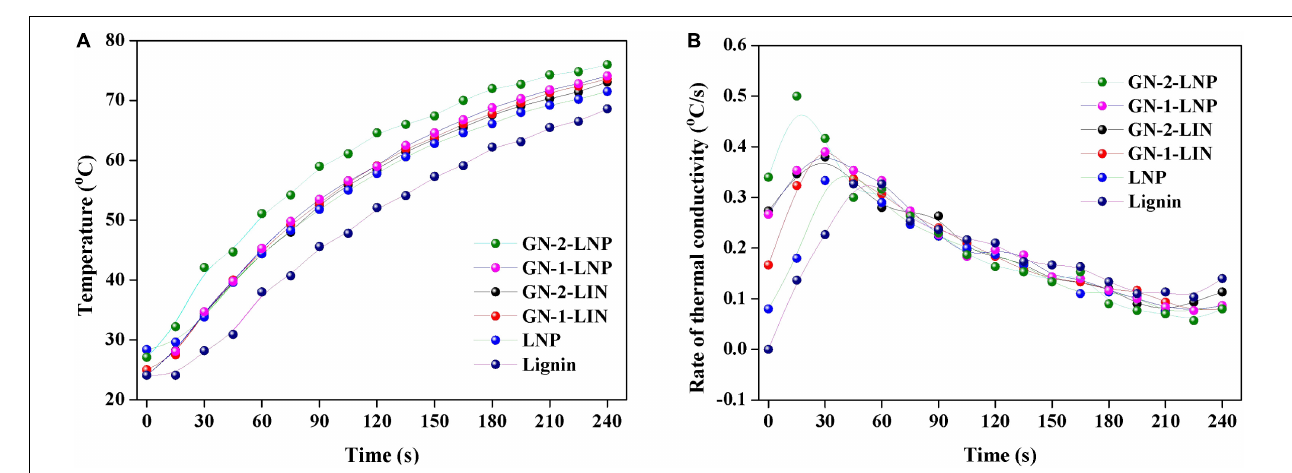
FIGURE 8 | (A) Real-time temperature and (B) rate of thermal conductivity curves.